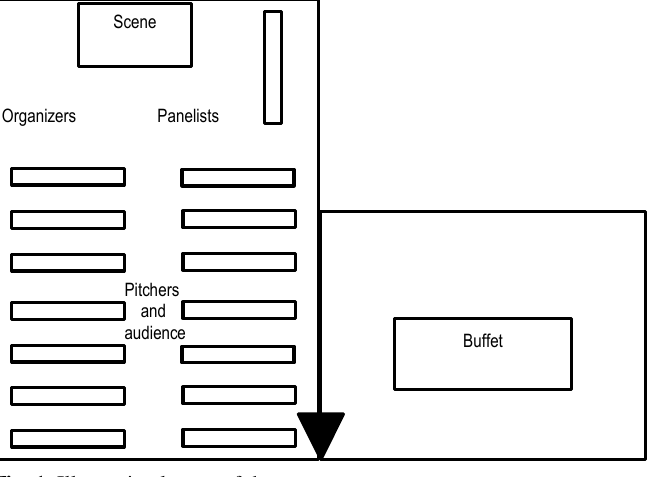
Fig. 1. Illustrative layout of the